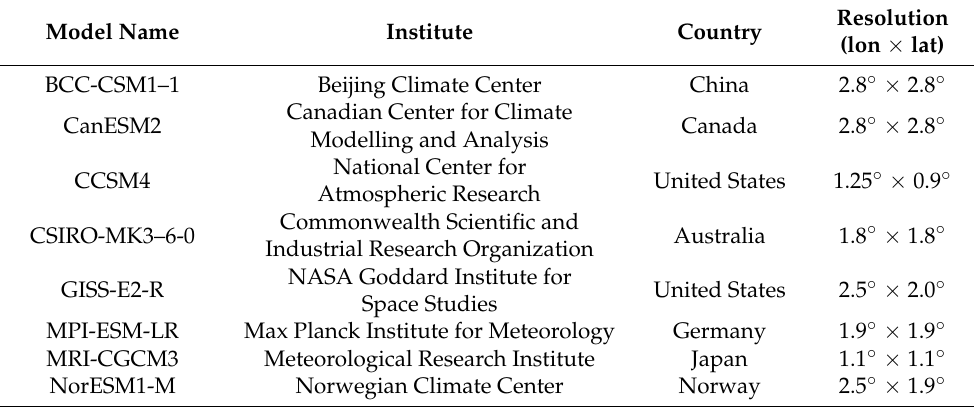
Table 1. Information on the 8 general circulation models.